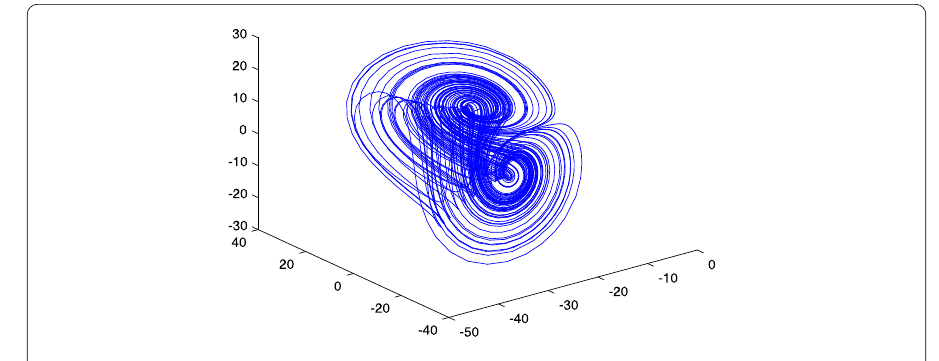
Figure 1 The chaotic trajectory of the system